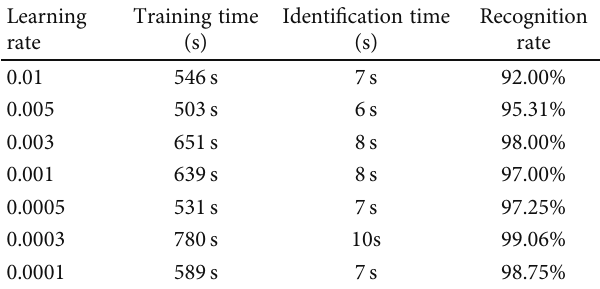
Figure 5: Volunteers ’ lip print images. Table 2: The recognition results of di ff erent learning